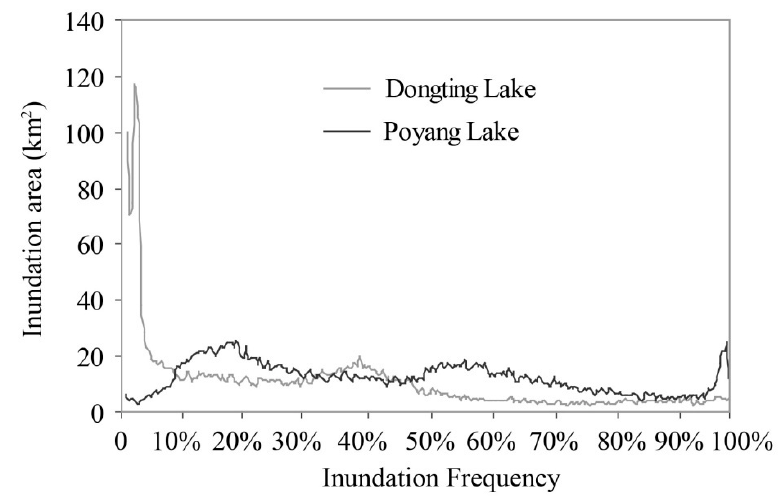
Figure 6. Variations in the inundation areas as a function of mean inundation frequency for Poyang Lake and Dongting Lake during 2000–2011.